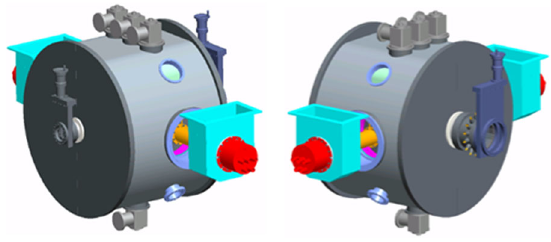
FIG. 23. 3D views of the fully assembled cryomodule.